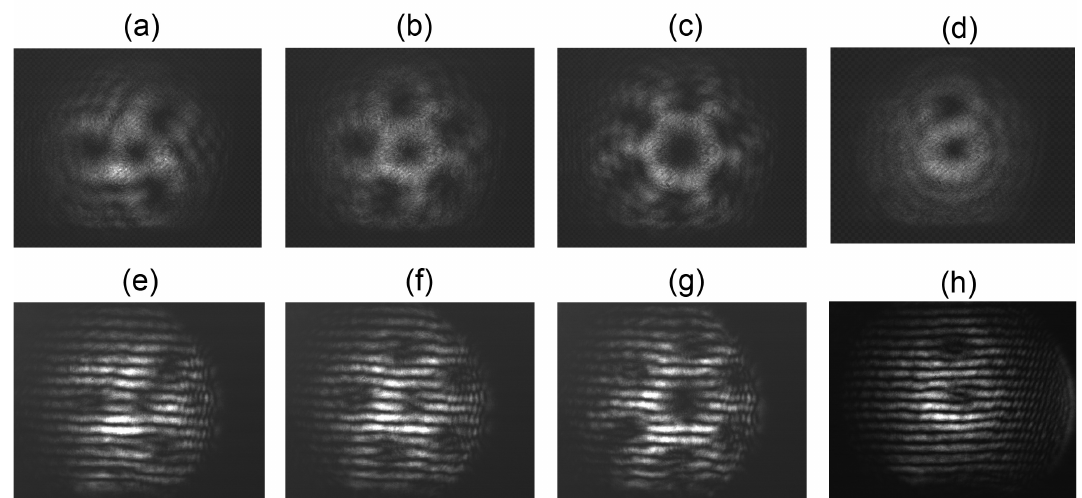
Figure 3. Images of equal-amplitude superpositions of modes with topological charges ( 1, − 2 ) in ( a ), ( 1, − 4 ) in ( b ), ( 2, − 4 ) in ( c ) and ( − 1, − 2 ) in ( d ). The images in the second row ( e – h ) are the shear interferograms of the superpositions above